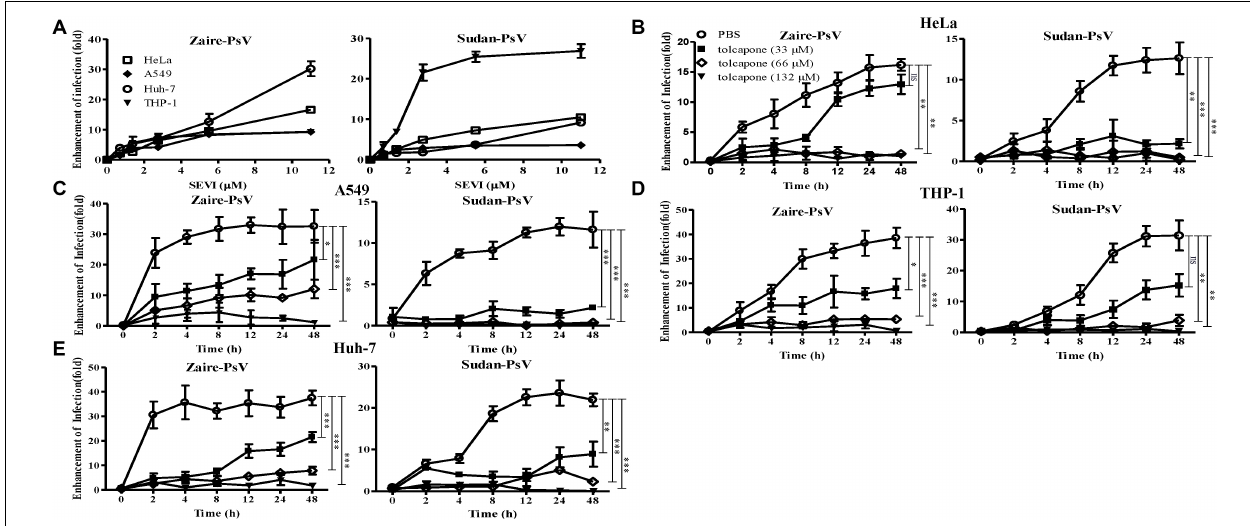
FIGURE 2 | Tolcapone attenuates the ability of semen-derived enhancer of viral infection (SEVI) fibrils to enhance pseudo-EBOV infection. (A) Increasing concentrations of mature SEVI fibrils were mixed with Zaire-pseudovirus (PsV) (left panel) and Sudan-PsV (right panel) at room temperature for 10 min, respectively. The mixtures were used to infect HeLa, A549, Huh-7, and THP-1 cells. Luciferase activities were determined 72 h later, and results are reported as n -fold enhancement of infection relative to that without SEVI. The data are represented as the mean ± SD of three independent experiments. (B–E) In the presence of tolcapone, PAP248–286 lost the ability to enhance Zaire-PsV (left panel) and Sudan-PsV (right panel) infection in various cells after agitation. PAP248–286 was agitated with tolcapone at various concentrations as described above. Pellets were collected at the indicated time points by centrifugation, which were then mixed with Zaire-PsV (left panel) and Sudan-PsV (right panel). Mixtures were then used to infect HeLa (B) , A549 (C), THP-1 (D), and Huh-7 (E) cells. Luciferase activities were determined 72 h later. The final concentration of SEVI was 11 µ M. The data represent the mean ± SD of three independent experiments. * p < 0.05; ** p < 0.01; *** p < 0.001; one-way